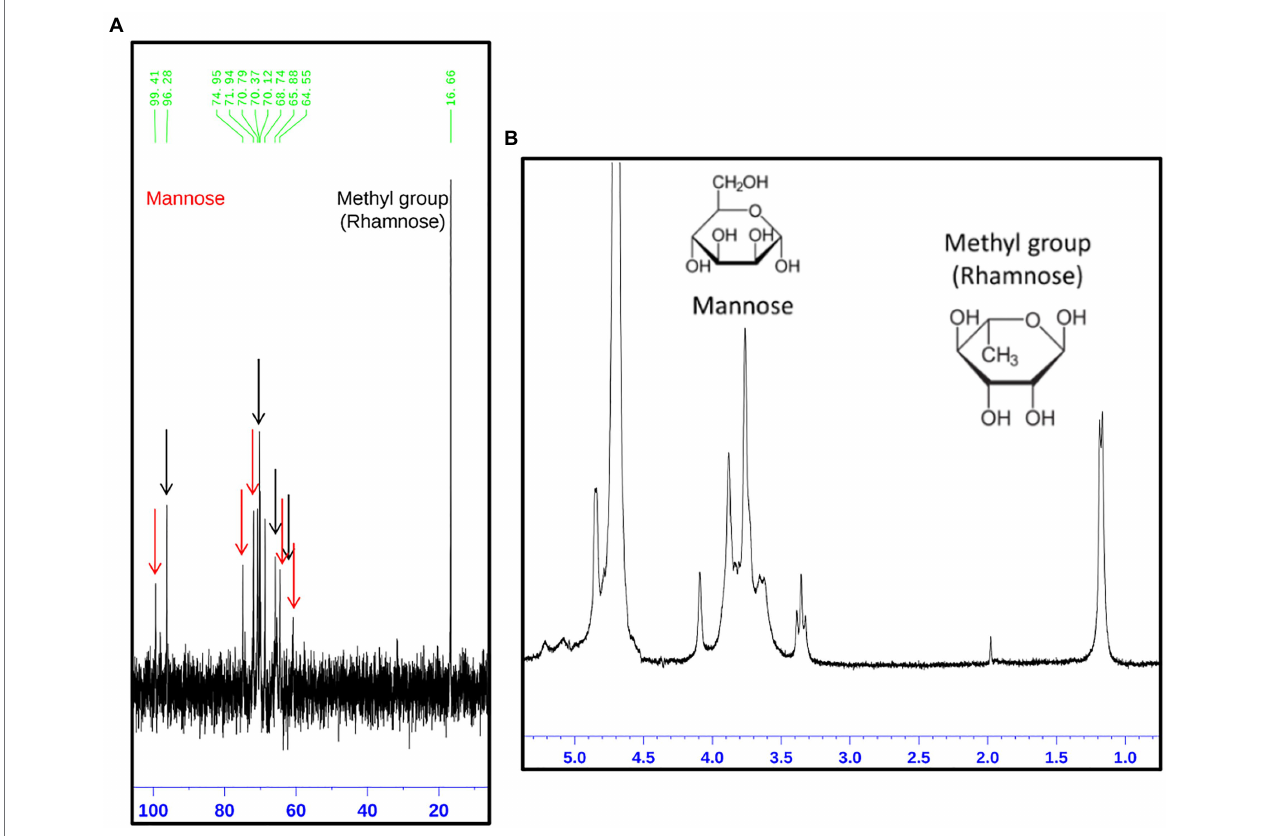
FIGURE 2 | Structural analysis of the rhamnomannan present in the Sporothrix strains employing 13 C-NMR and 1 H-NMR ( A,B , respectively). On the image, the spectrum corresponding to the rhamnomannan fraction of S. schenckii strain MYA 4820 is presented as a representative spectrum of both, S. schenckii and S. brasiliensis strains under study. (A) The signals corresponding to the carbon atoms in the mannose and rhamnose residues are shown as arrows, red for mannose and black for rhamnose. The corresponding signals are shown in Table 1 . (B) Show the presence of the methyl group belonging to rhamnose (1.18 and 1.17 p.p.m.) and the signals correspond to the proton bound to carbon 5 next to the methylene group for carbon 6 in the mannose ring (3.32, 3.35, and 3.39